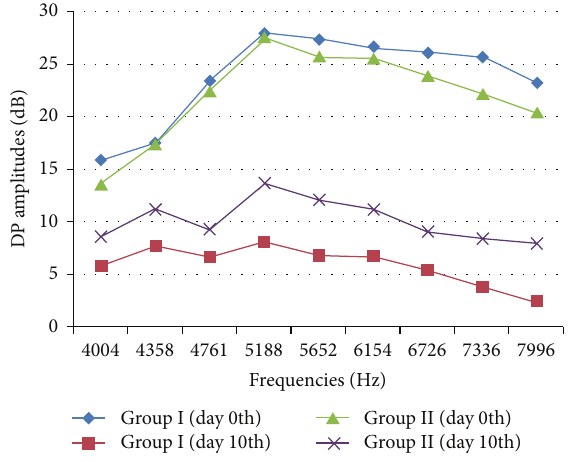
Figure 3: I/O measurement at 𝑓 1 /𝑓 2 = 65/55 in group I and group II, DP graph before and after cisplatin